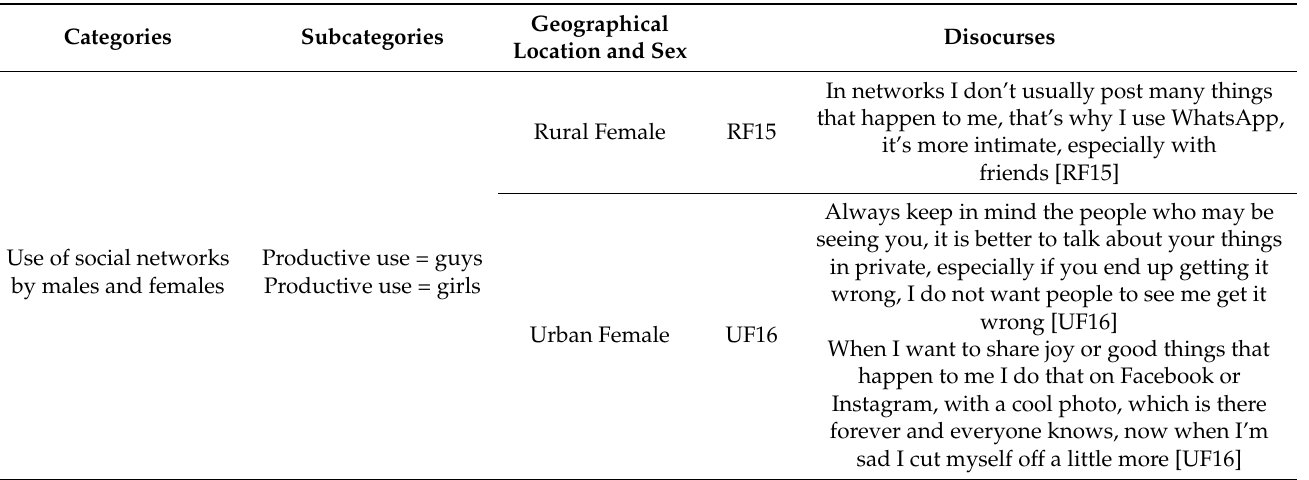
Table 12. Expressing feelings on social